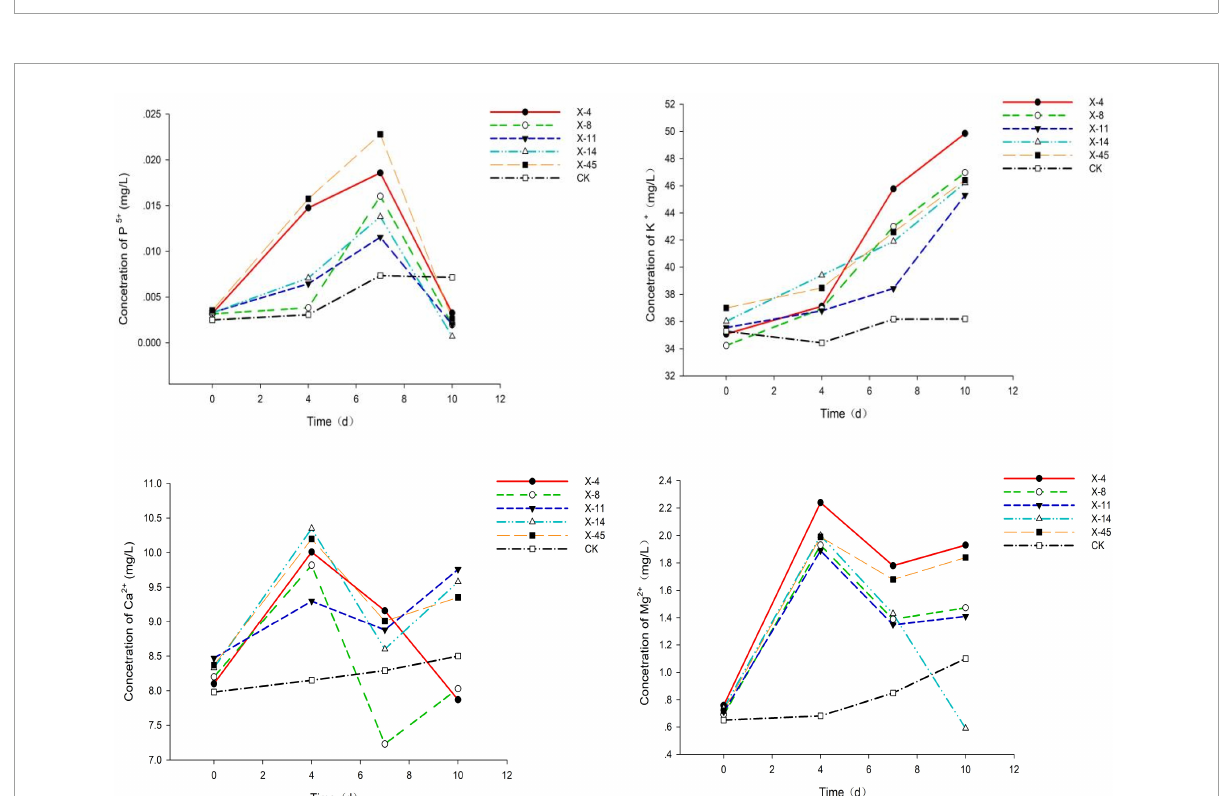
FIGURE2 Phosphorus, potassium, calcium, and magnesium release from the fermentation broth of five strains of bacteria.